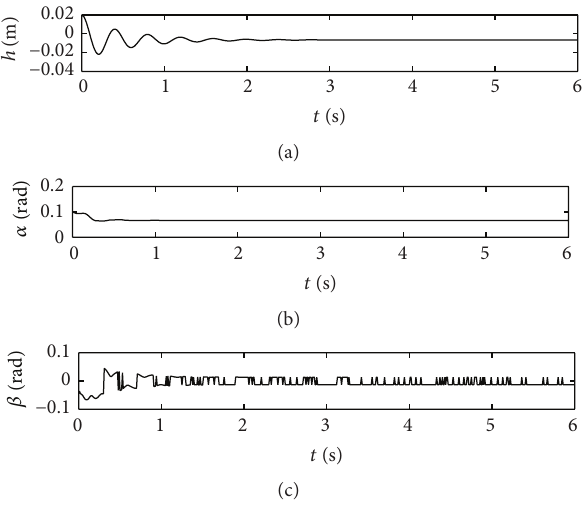
Figure 8: ILC control for graded gust, 𝑤 0 = 1 , 𝑈 = 16 m/s: (a) plunge displacement ℎ (m); (b) pitch angle 𝛼 (rad); (c) control input 𝛽 (rad). Table 1: System